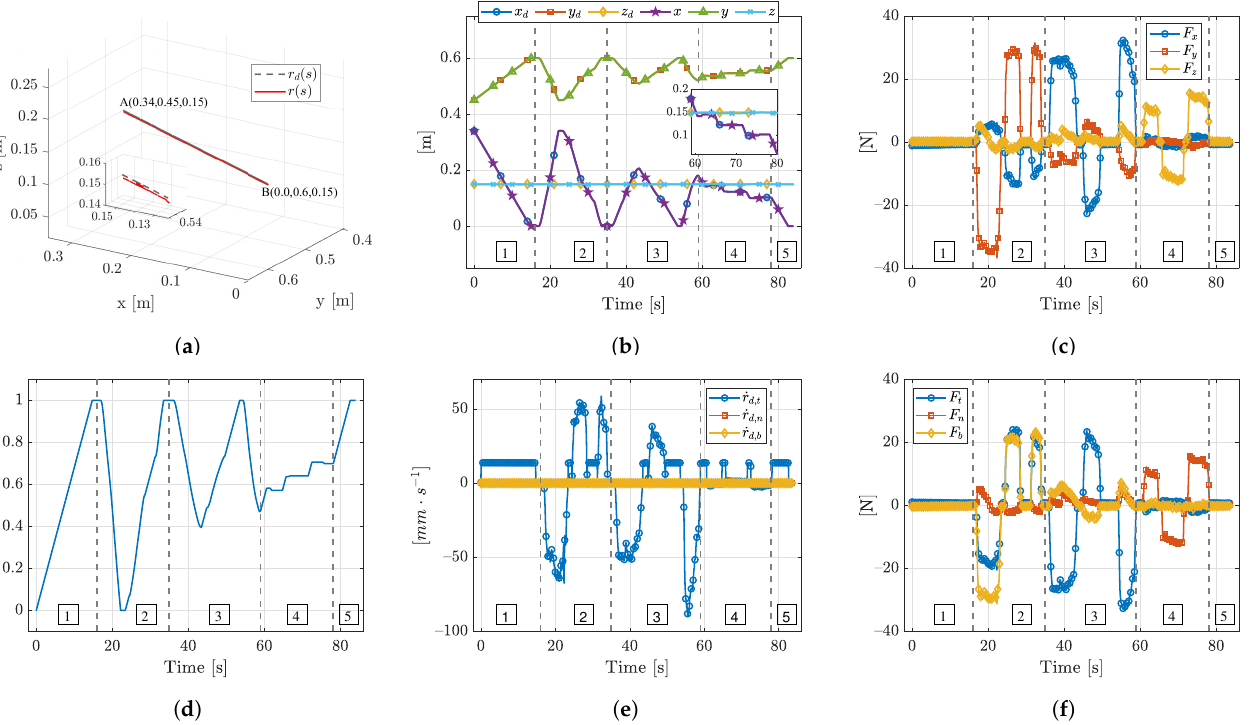
Figure 6. Linear motion path tracking test. Numerals 1–5 are used to separate regions where forces are applied in different directions: 1 and 5—free-motion, 2—force applied along y-axis of robot frame, 3—force applied along x-axis of robot frame, 4—force applied along z-axis of robot frame. ( a ) Desired and actual 3D path in robot base frame. ( b ) Desired and actual Cartesian positions. ( c ) Forces in robot frame. ( d ) Parameter s. ( e ) Desired Velocities in TNB frame. ( f ) Forces in TNB